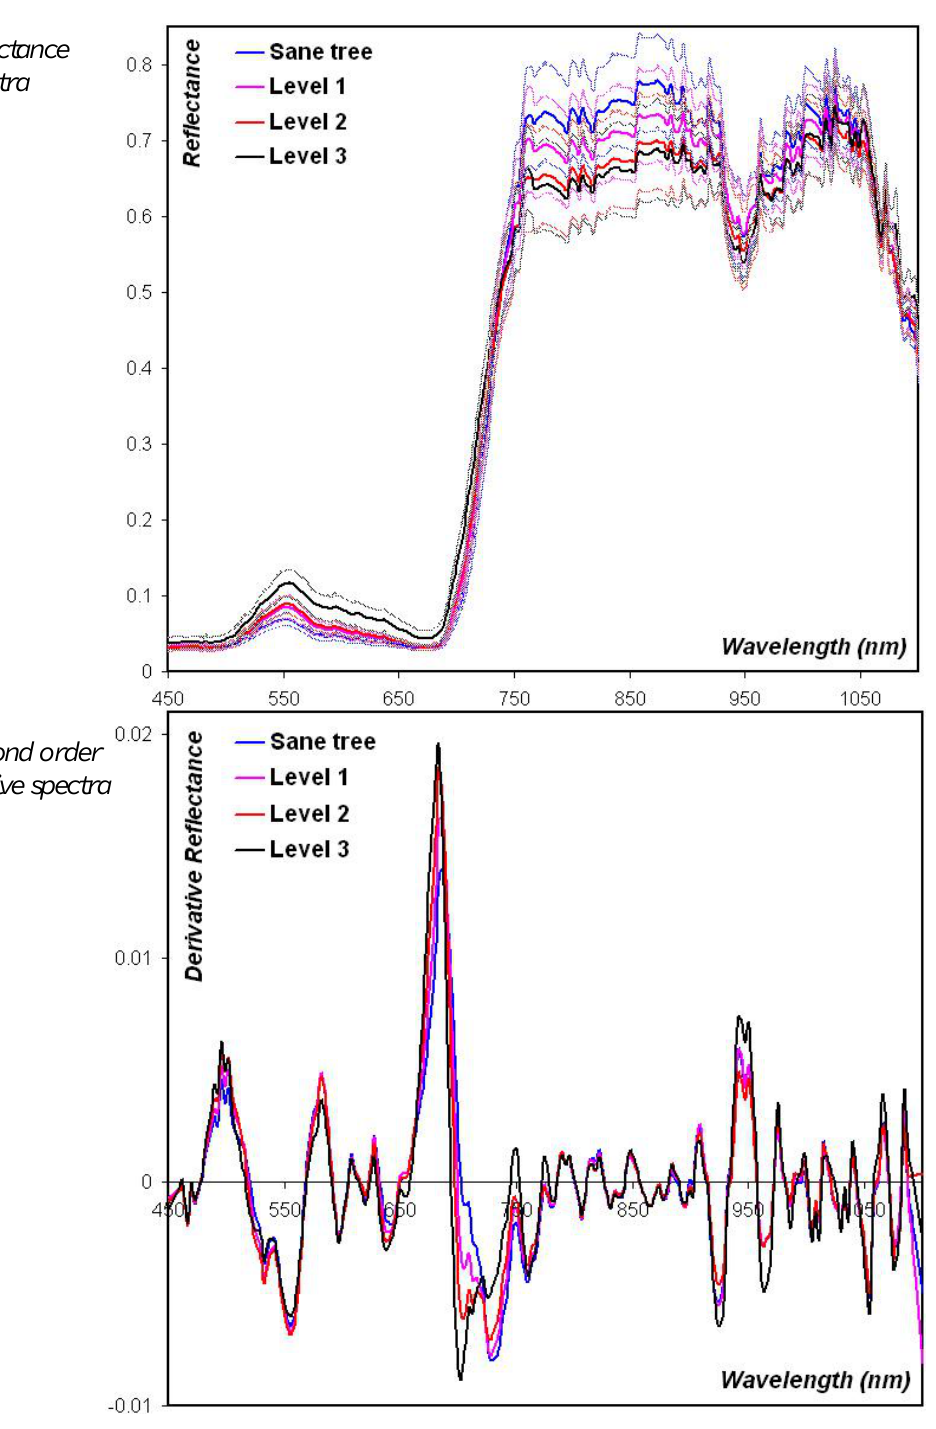
Figure 4. (a) Mean hyperspectral reflectance for healthy oil palms (blue) and attacked by Ganoderma at the respective levels 1 (magenta), 2 (red), and 3 (black). Faint lines indicate the contours of the envelope based on standard deviation. (b) Mean derivative filtered spectra at the 2 nd order of derivation for each